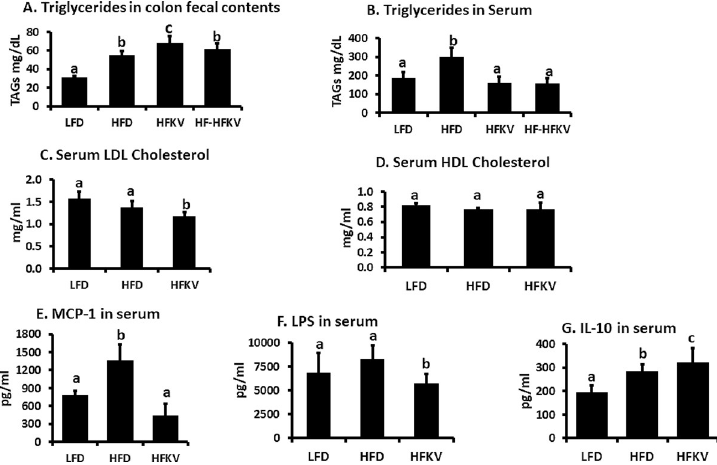
Fig 4. Supplementation with kale lowered serum TAGs, LDL cholesterol, endotoxemia and inflammation markers. TAGs were analyzed by a colorimetric kit. LDL and HDL cholesterol were quantified by Elisa kits. All data was subjected to after ANOVA. (A). TAGS in colon fecal samples were higher in HFD compared to LFD fed group (P < 0.05; n = 9). TAG levels in HFKV samples were higher than those in HFD and LFD (P < 0.05; n = 9). (B). TAG levels in serum were higher in HFD compared to LFD fed group (P < 0.05; n = 9). TAG levels in HFKV samples were lower than those in HFD (P < 0.05; n = 9). (C and D). LDL cholesterol levels in HFKV samples were lower than those in HFD and LFD (P < 0.05; n = 9). HDL cholesterol levels were not different between the 3 diet groups (P = ns; n = 9). LPS, MCP-1 and IL-10 levels in serum were quantified using mouse ELISA kits. All data was subjected to ANOVA. (E) The HFD increased levels of LPS compared to LFD (P < 0.05; n = 9). The HFKV diet attenuated the increase in LPS to levels below those of both the HFD diet and LFD (P < 0.05; n = 9). (F) The HFD diet increased levels of MCP-1(Ccl2) compared to LFD (P < 0.05). The HFKV diet attenuated the increase in MCP-1 to levels below those of both the HFD diet and LFD diet groups (P < 0.05; n = 9). (G) The HFD diet increased the levels of IL-10 compared to LFD diet (P < 0.05). The HFKV diet further increased IL-10 to levels higher than those of the HFD diet group (P < 0.05; n = 9). ‘a’ Different letters indicate significant differences after ANOVA and Tukeys test of multiple comparisons at P < 0.05. group 3 and 4 to levels below those of both the LFD and HFD groups (P < 0.05). The HFD diet induced an increase in triglycerides in colon fecal samples compared to the LFD (P < 0.05; n = 9). The HFKV diet increased triglycerides in colon fecal contents in both group 3 and 4 to levels higher than those of both the LFD and HFD fed groups (P < 0.05; n = 9) (Fig 4B). Serum LDL cholesterol levels in LFD and HFD group were not different. Supplementation with kale vegetable lowered LDL cholesterol level compared to both LFD and HFD groups (P > 0.05). HDL cholesterol levels in all diet groups were not different (P = ns) (Fig 4). Endotoxemia and inflammation markers in serum The HFD increased ccl2 (MCP-1) concentrations in serum compared to LFD. MCP-1 concen- tration was significantly lower in HFKV diet group compared to HFD and also compared to that of LFD group (P < 0.05; n = 9) (Fig 4A). The HFD diet increased LPS concentrations in serum. LPS concentration was significantly lower in HFKV diet group compared to HFD and significantly lower in HFKV diet group compared to LFD (P < 0.05; n = 9) (Fig 4B). The HFD diet increased IL-10 concentrations in serum. The HFKV diet further increased serum IL-10 to levels higher than those of both the HFD and LFD groups (Fig 4C).